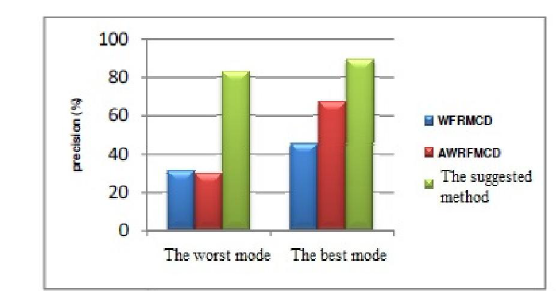
Fig. 1. A comparison of the ‘recall’ value from the suggested method and that of the methods ‘WRFMCD’ and